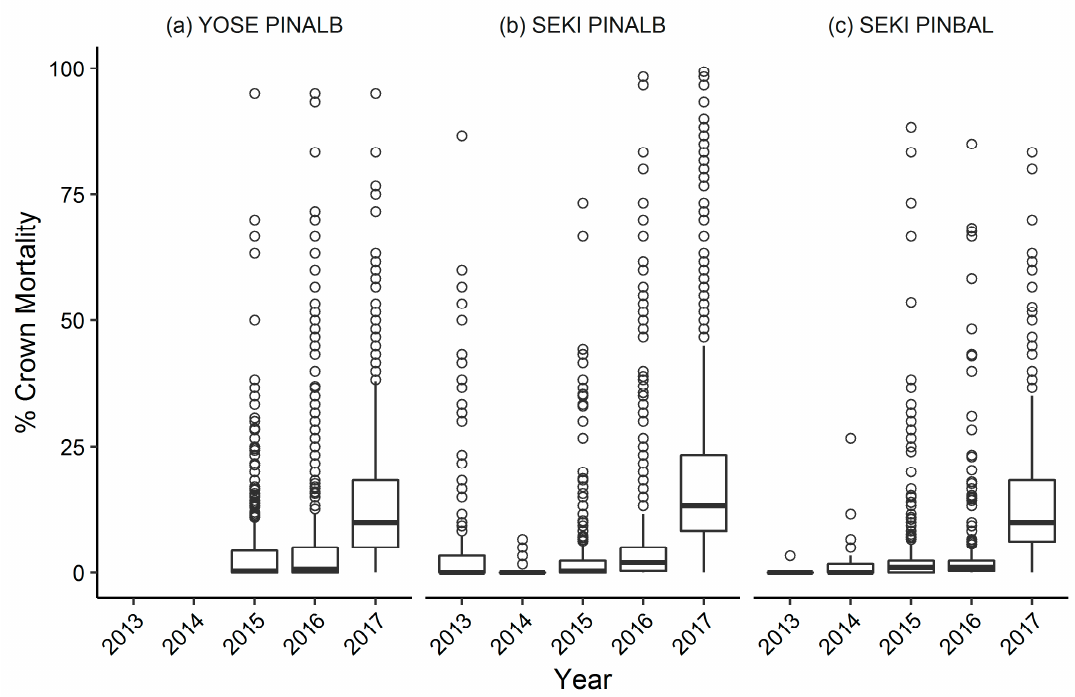
Figure 8. Histogram of all live whitebark pine diameter at 1.37 m (DBH) in Yosemite National Park (YOSE), CA, USA ( a ) and Sequoia and Kings Canyon National Parks (SEKI), CA, USA ( b ). DBH ranged from 0.4 to 78.3 cm in YOSE and 0.4 to 136.5 in SEKI.